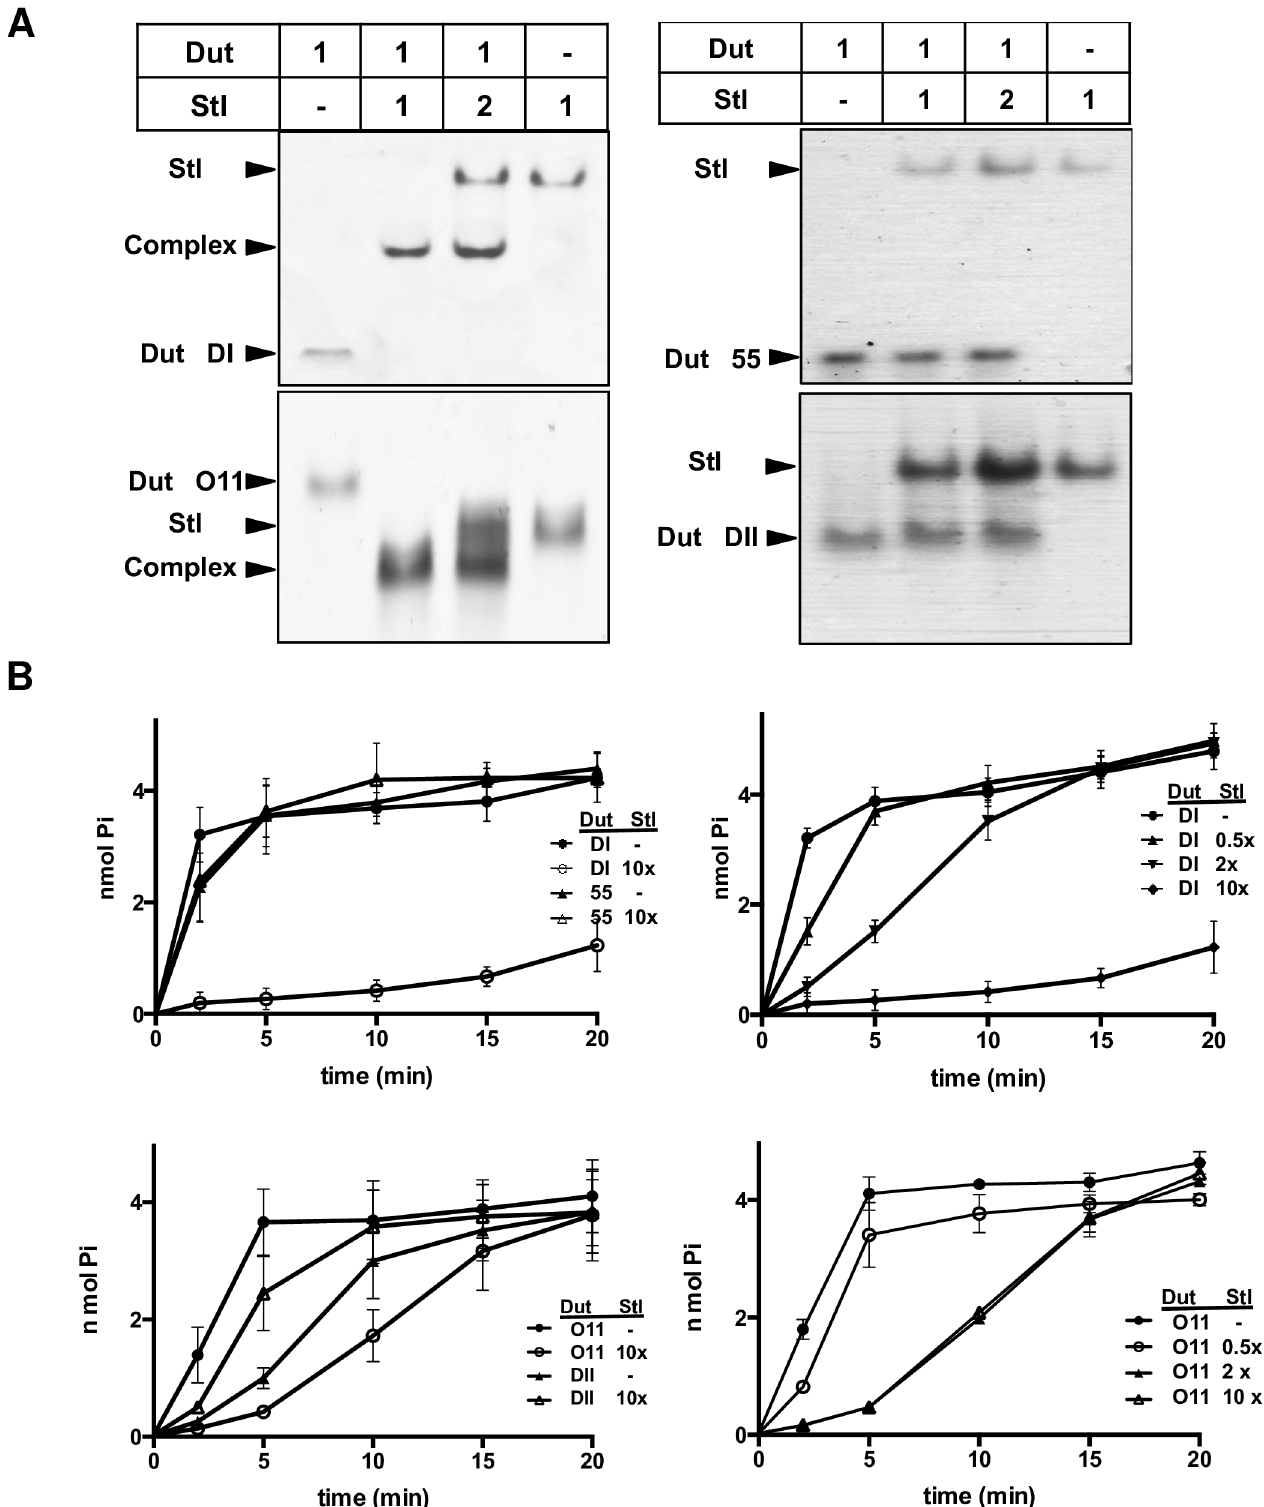
Fig 3. Interaction between Stl and the allelic variants of dimeric Duts from S . aureus phages and the effect on dUTPase activity. (A) The capacity of the ϕ DI, ϕ O11, ϕ Phi55and ϕ DII dimeric Duts to form a complex with Stl was checked by Native-PAGE maintaining a constant amount